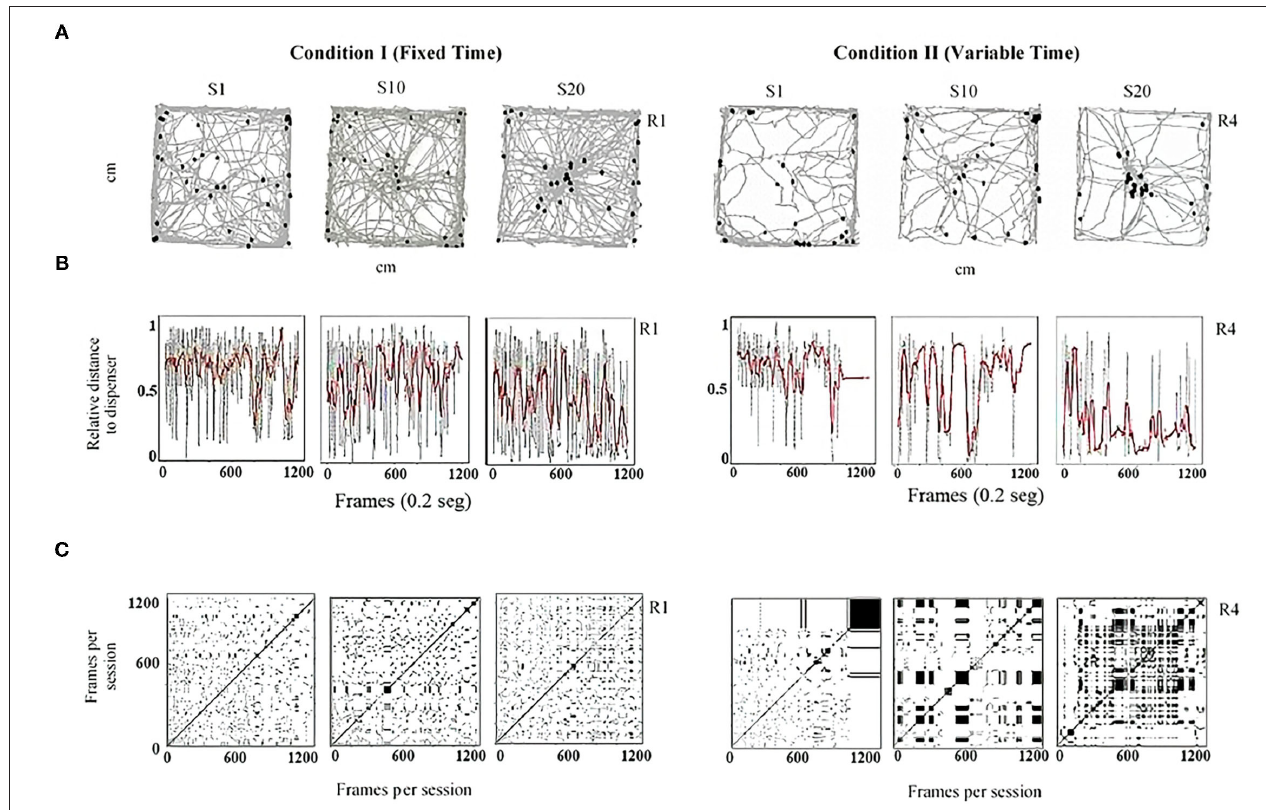
FIGURE 2 | Representative within-subject results of the behavioral continuum for the initial (Session 1), intermediate (Session 10), and last session (Session 20) for one rat under FT (R1, left panels) and one rat under VT (R4, right panels). Each column depicts a session. (A) shows the routes of the rat (gray lines) and the rat’s location at the moment of water delivery (black dots) in a bidimensional representation of the experimental chamber. (B) depicts the relative distance to the dispenser (Y-axis) moment to moment (X-axis). Finally, (C) shows recurrence plots. See the text for a complete